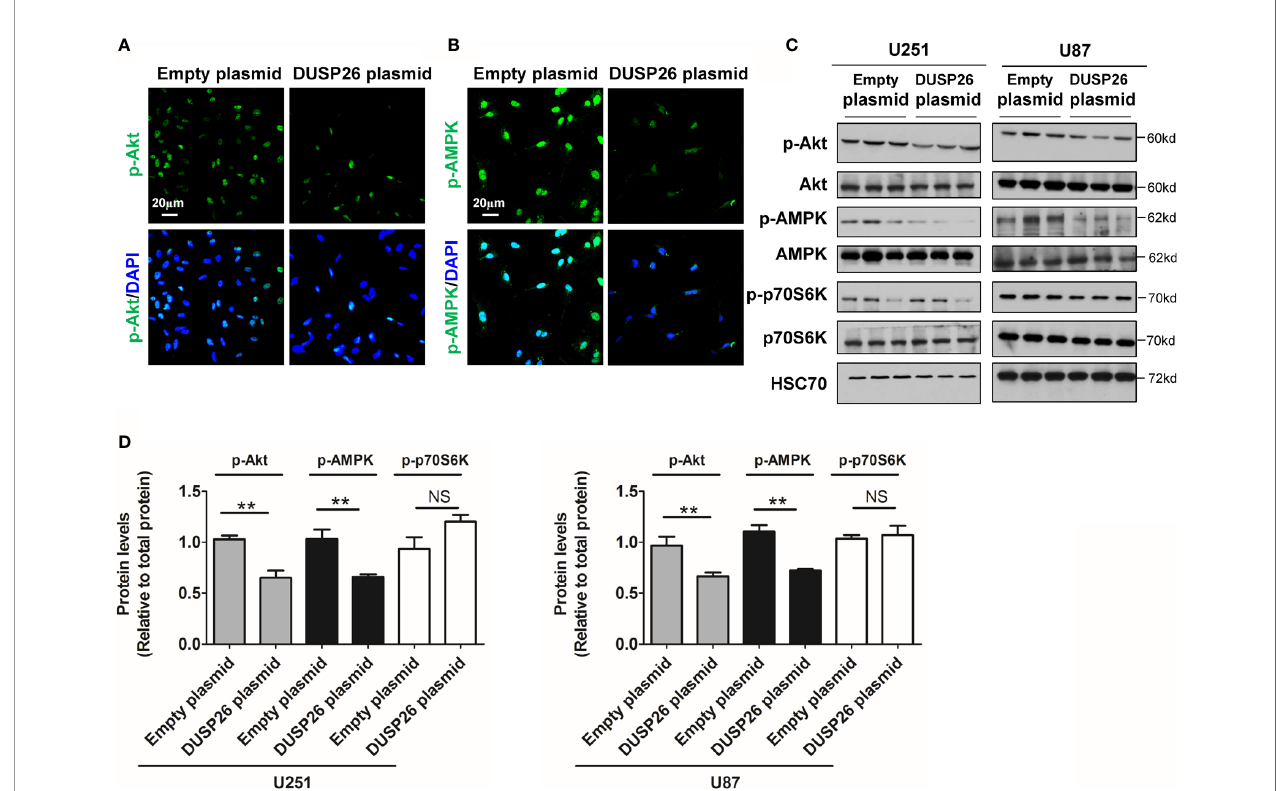
FIGURE 7 | Effect of DUSP26 overexpression on the Akt signaling pathway. (A) Representative images of immuno fl uorescence based detection of p-Akt (green) in U251 cells transfected with empty vector or DUSP26 cassette, cells were analyzed 48 h after transfection, nuclei were counterstained with DAPI. (B) Representative images of immuno fl uorescence based detection of p-AMPK in U251 cells transfected with empty vector or DUSP26 cassette and processed as described under (A) . (C) Representative images of western blots showing relative p-Akt (Thr308), Akt, p-AMPK (Thr172), AMPK, p-p70S6K (Ser371), and p70S6K in lysates of U251 or U87 cells transfected with empty vector or DUSP26 expression plasmid, cells were lysed 48 h after transfection and analyzed in triplicate, HSC70 was used as a loading control. (D) Quanti fi cation of the Western blots depicted in (C) , **p < 0.01, NS, not signi fi